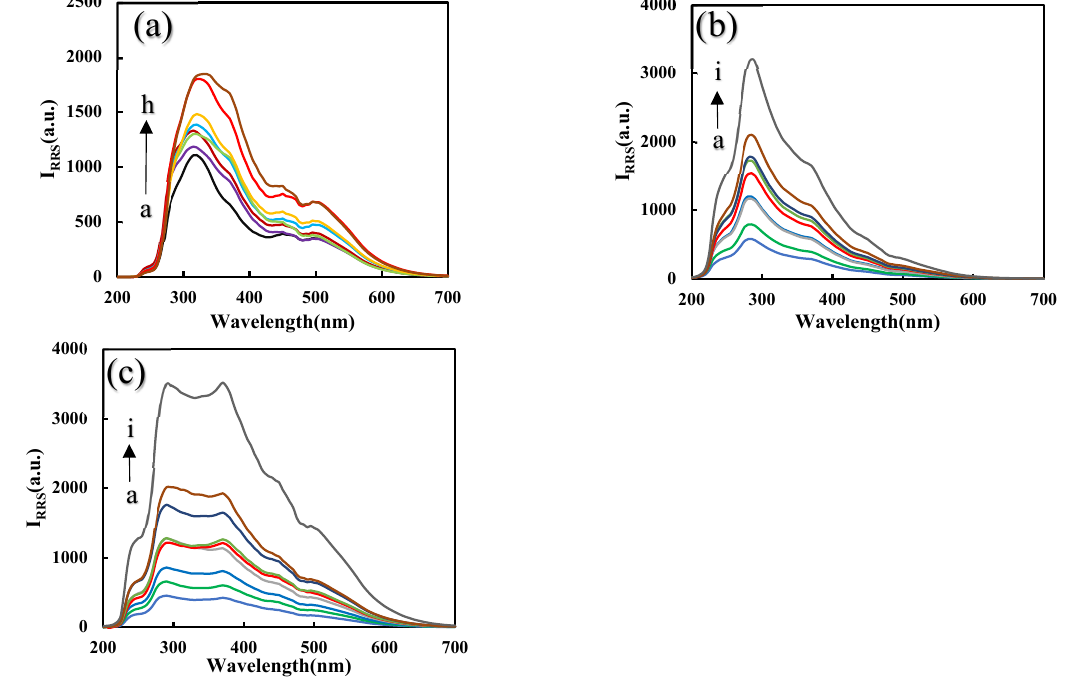
Figure 6. RRS spectra of the analysis system. ( a ) a to h: (0, 0.067, 0.13, 0.2, 0.27, 0.33, 0.67, 1) nM Pb 2+ + Apt + PN 3 + AgNO 3 + SF. ( b ) a to i: (0, 0.05, 0.1, 0.2, 0.3, 0.4, 0.5, 1, 2) nM Pb 2+ + PN 3 + Apt + HM + AgNO 3 + SF; ( c ) a to i: (0, 0.05, 0.1, 0.2, 0.3, 0.4, 0.5, 1, 2) nM Pb 2+ + PN Fer3 + Apt + HM + AgNO 3 + SF.